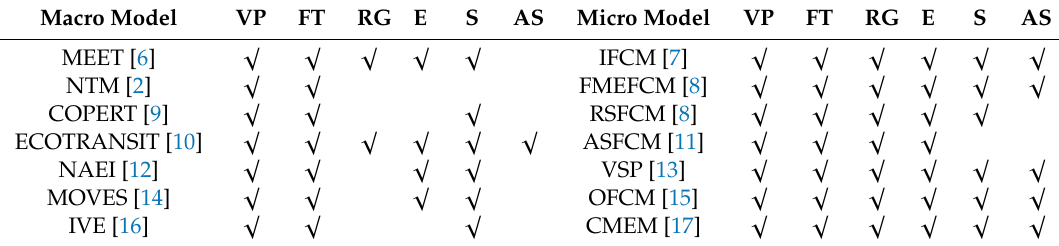
Table 1. Fuel consumption / carbon emission